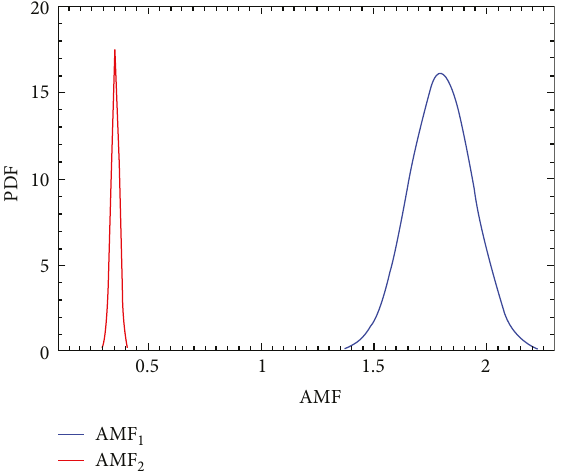
Figure 12: Probability density function of AMF ( E = 2 , △ γ